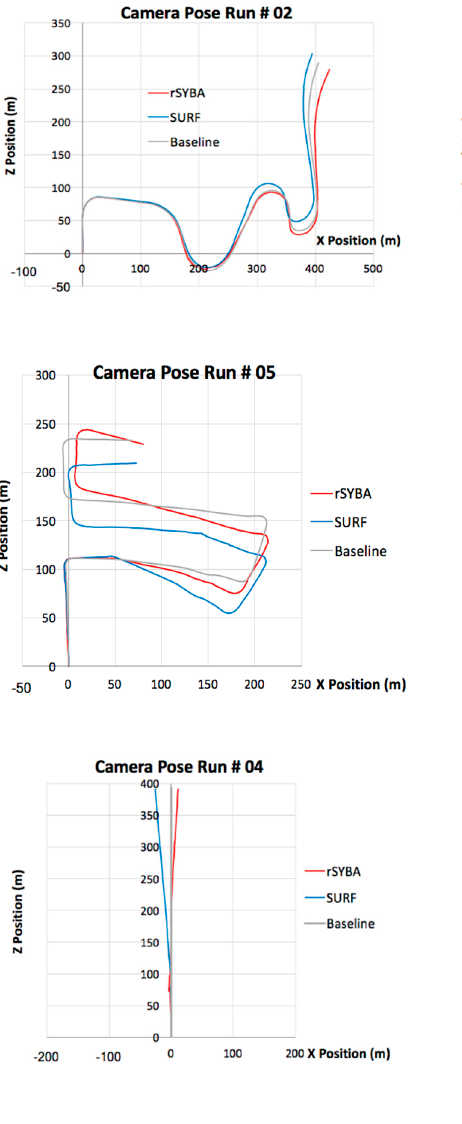
Figure 11. Camera pose and number of correct matches for the scene of ( a ) urban and country environments (Run #2), ( b ) urban environment (Run #5), and ( c ) country environment (Run #4).